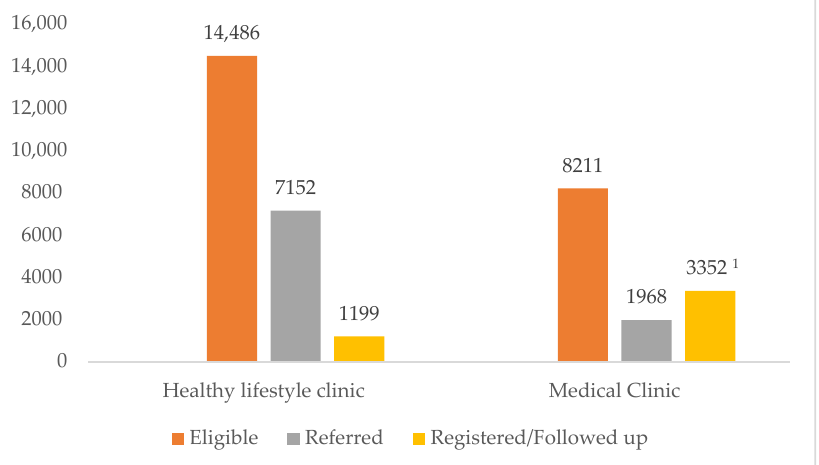
Figure 4. Eligibility for referral, referral status, and follow-up of the individuals who underwent screening for NCD risk factors in the selected PMCIs supported by the PSSP in Sri Lanka from June